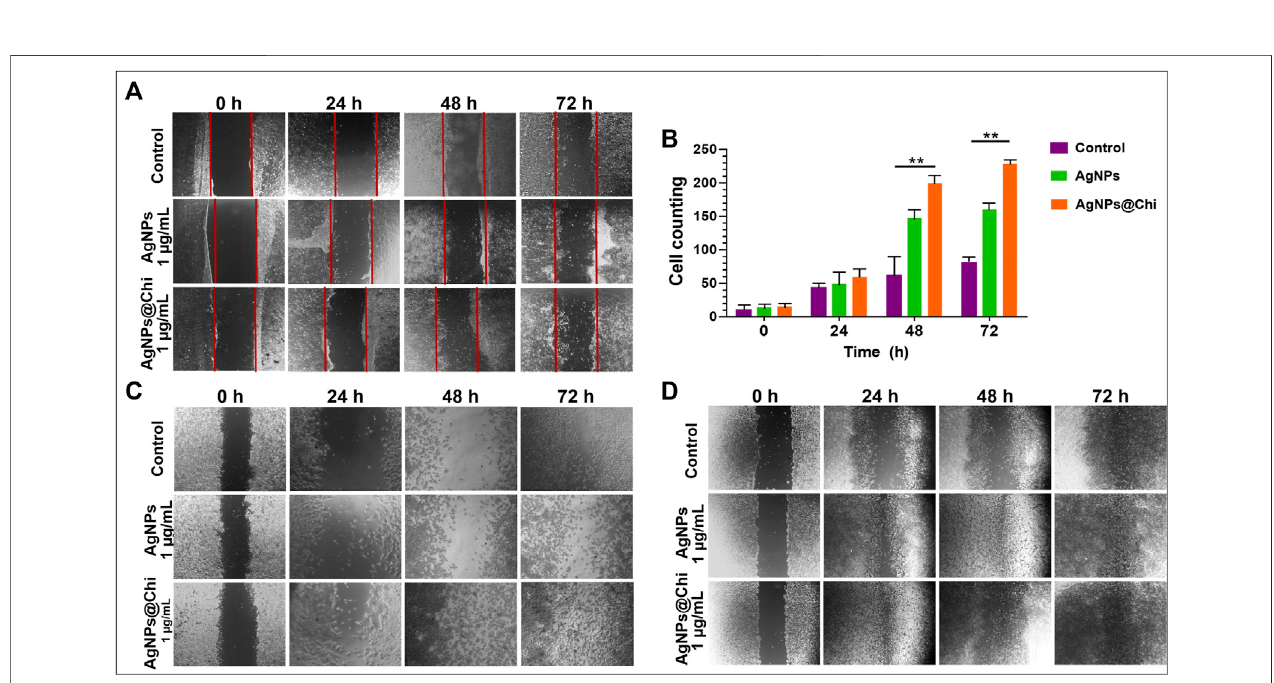
FIGURE 2 | Hemolytic activity of silver nanocomposites. Sheep red blood cells (1 × 10 8 cells/ml) were exposed to NCs for 1 h. Hemoglobin, proportional to hemolysis, was measured at 540 nm. The data represents means with standard deviations of three independent assays performed by triplicate. The statistics analysis was performed using Sidak ’ s multiple comparison test, * p < 0.05; ** p < 0.01; *** p < 0.001.